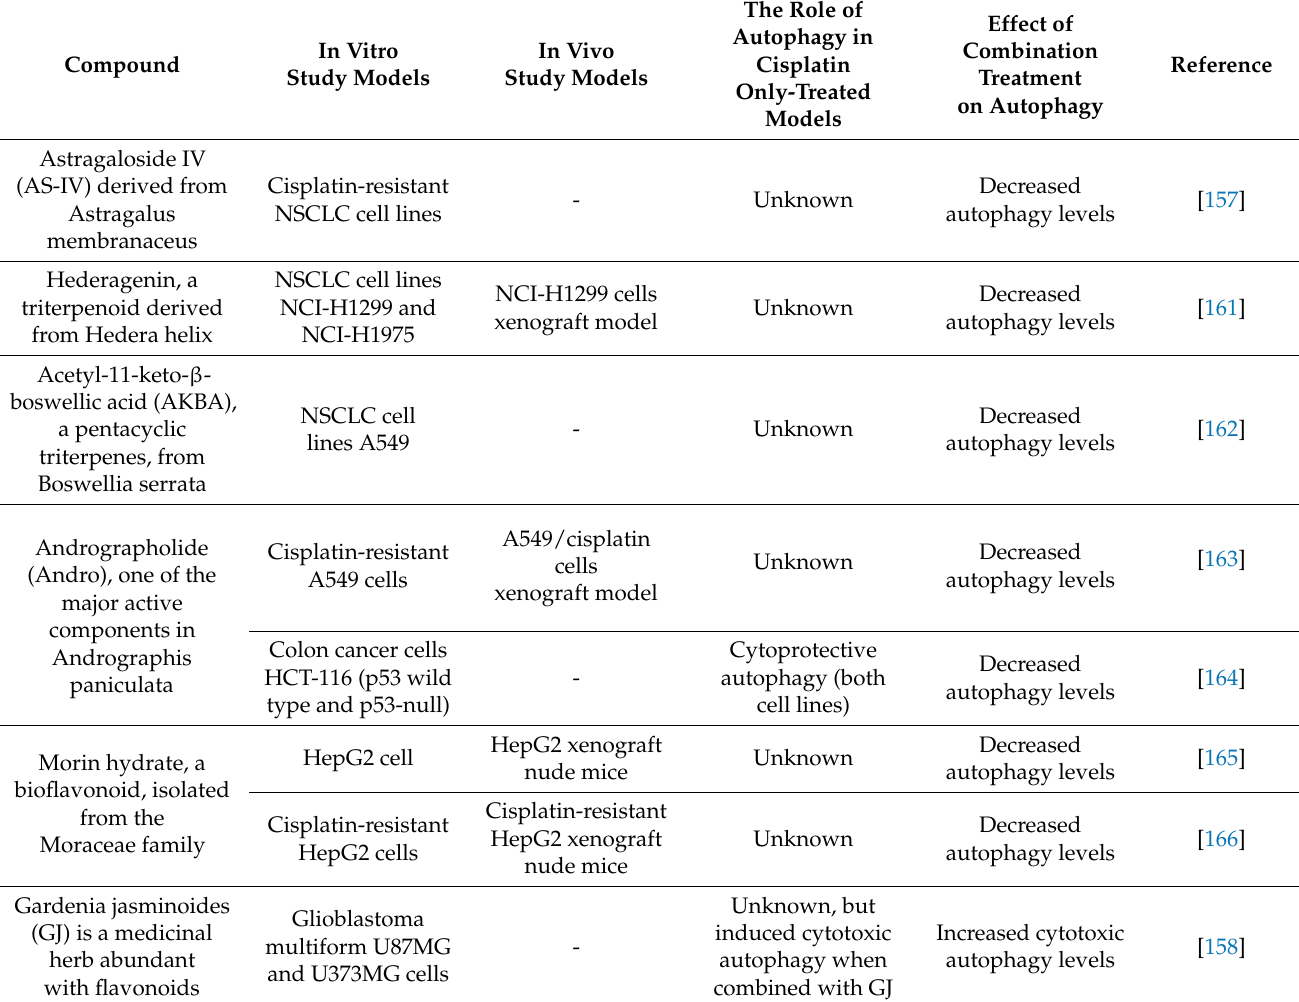
Table 2. Role of autophagy in synergistic effects of natural products and